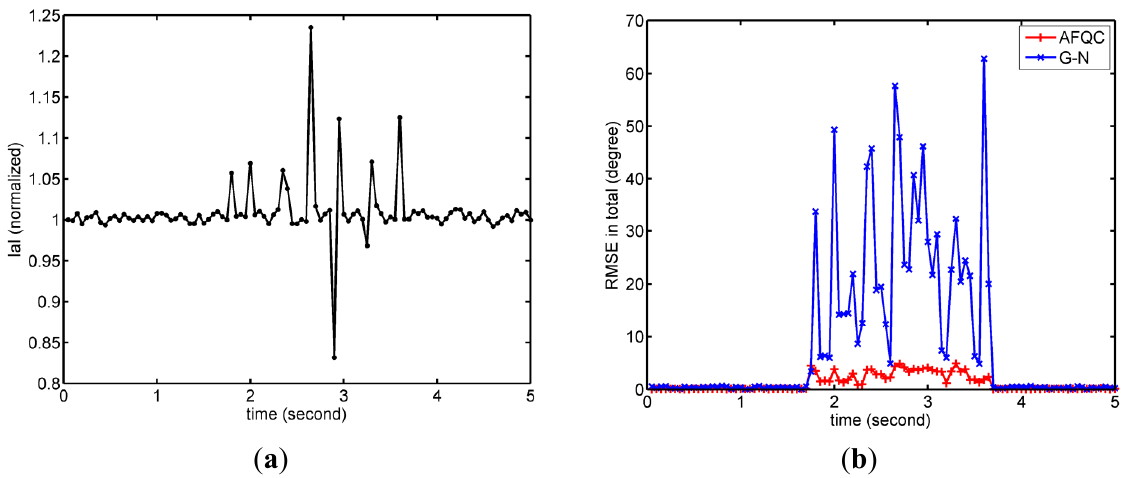
Figure 12. Typical results for estimation errors when acceleration disturbances applied. ( a ) Magnitude of specific force. Acceleration’s signals become variable when the sensor is moving; ( b ) Orientation outputs of AFQC and